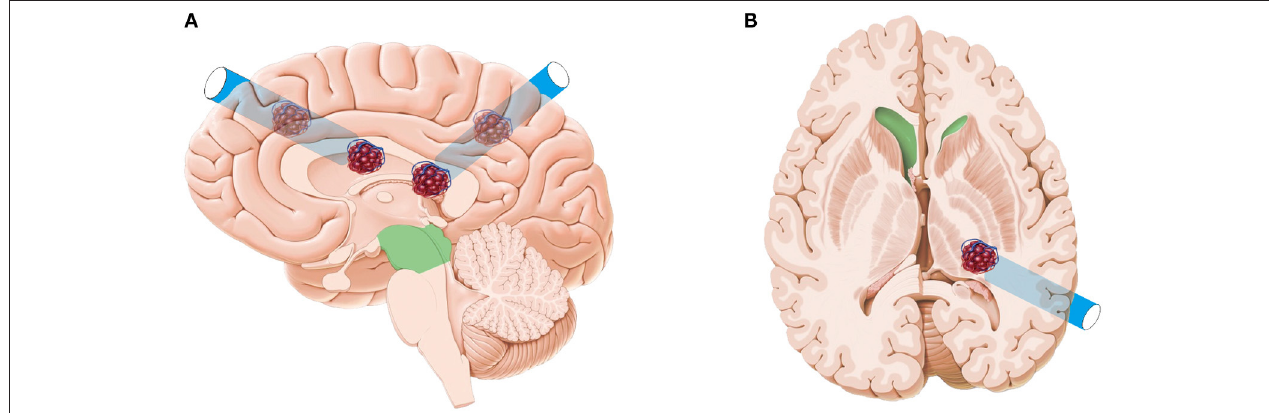
FIGURE 1 | Artist’s illustration depicting the frontal approach, paramedian parietal approach (A) , and parietooccipital approach (B) . The original pictures (brain anatomy and CCM) were from a website. This was designed by one of the authors with Adobe Photoshop CS5 and CorelDRAW 2019.